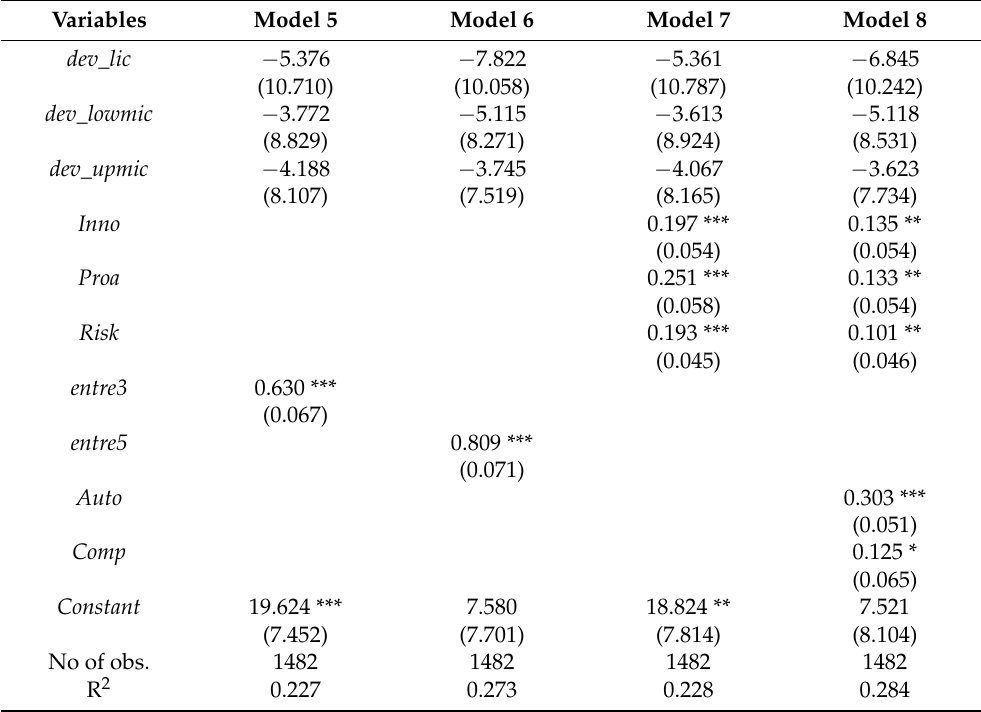
Table 3. Empirical results for the second dependent variable— hpol (public healthcare